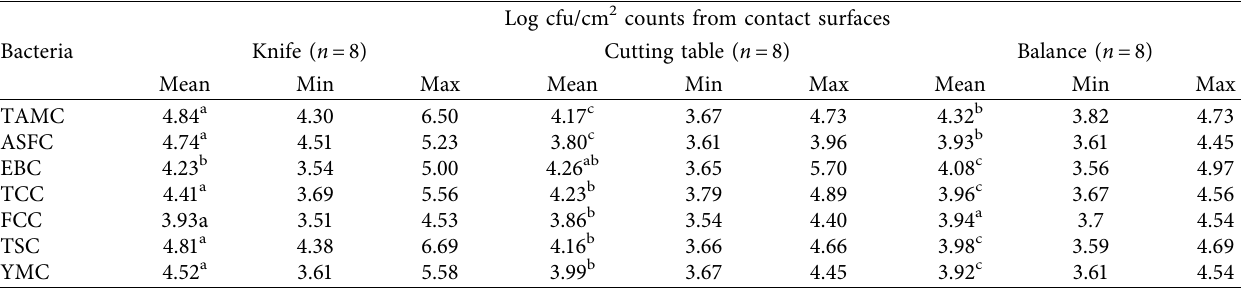
Table 5: Microbial count from contact surface (knife, cutting table, and balance) expressed in log cfu/cm 2 ± standard deviation. Bacteria